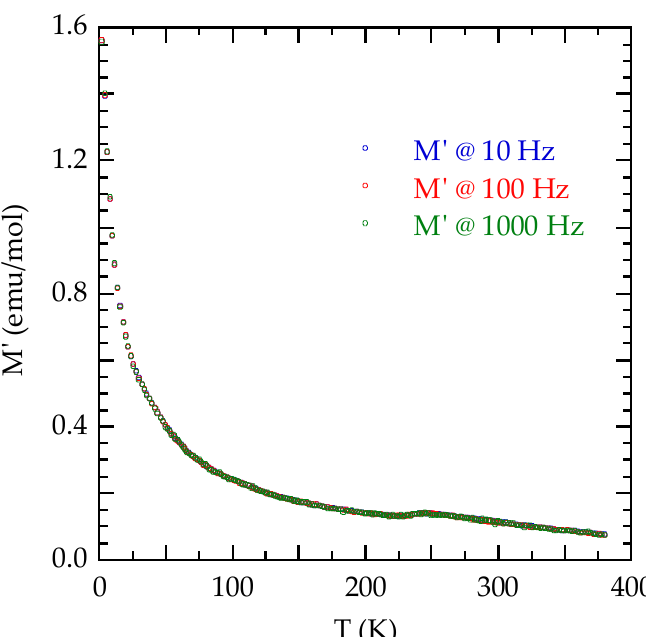
Figure 11. Real part of the AC magnetization as a function of temperature at three selected frequencies for the micrometric sample. Data were collected using a null DC magnetic field and an AC magnetic field H AC = 3.5 Oe.